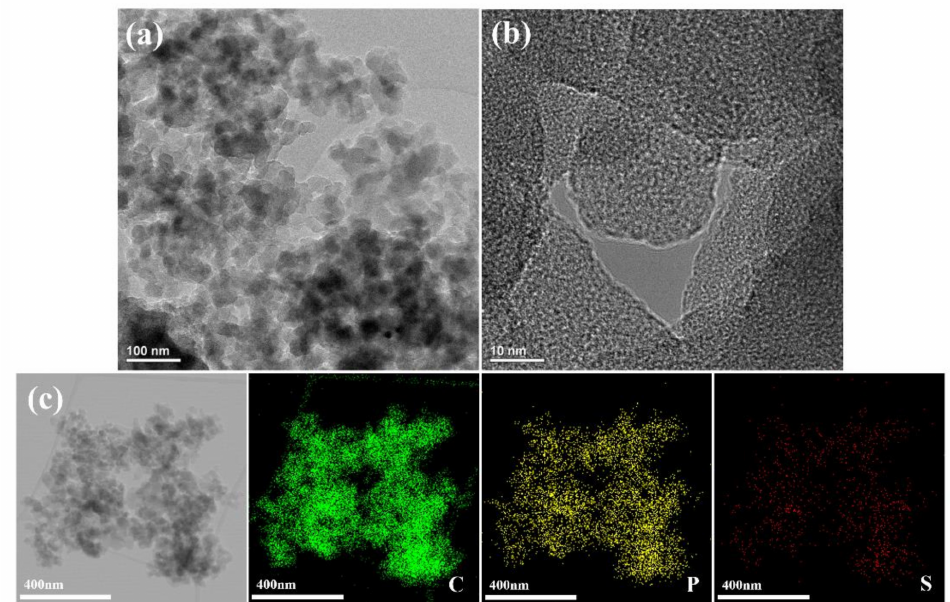
Figure 2. Morphology of SP/C ( a ) TEM image, ( b ) HR-TEM image and ( c ) EDS